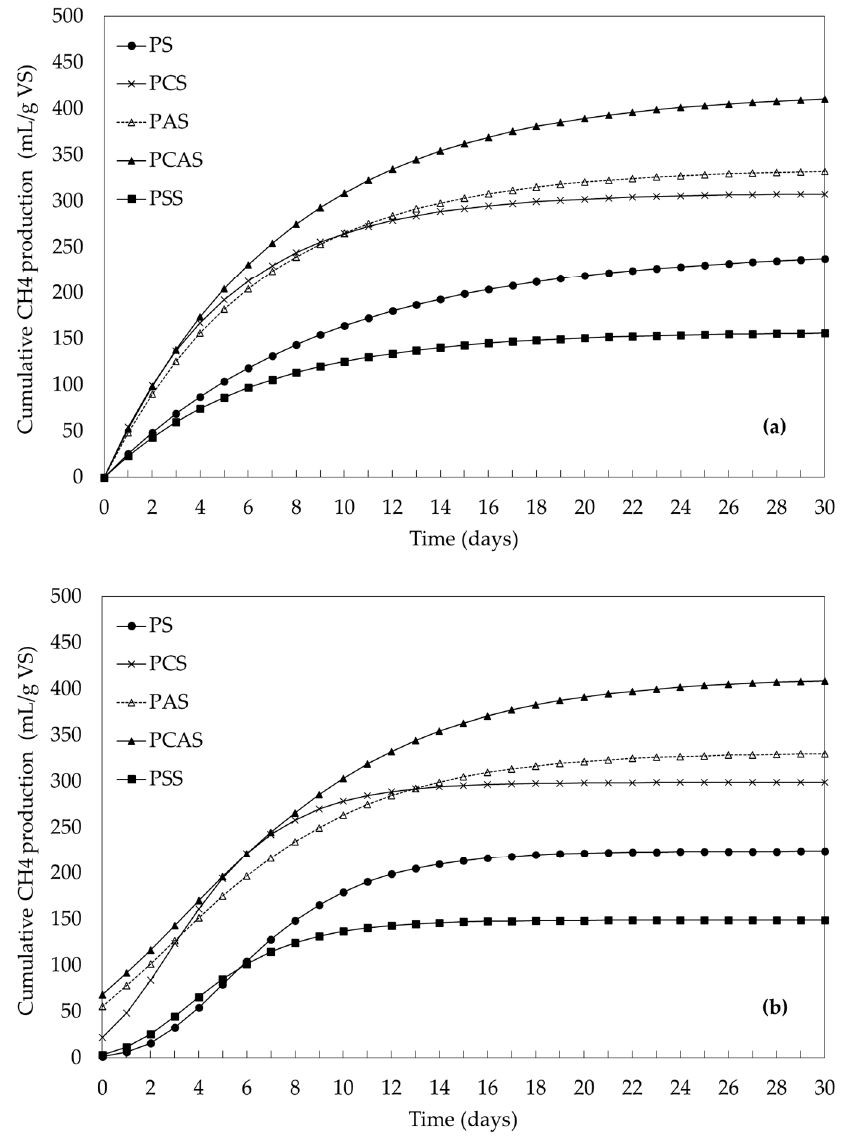
Figure 8. Kinetics modeling for SIR = 1:1 g VS substrate/g VS IN. ( a ) First order kinetics model; ( b ) modified Gompertz model.